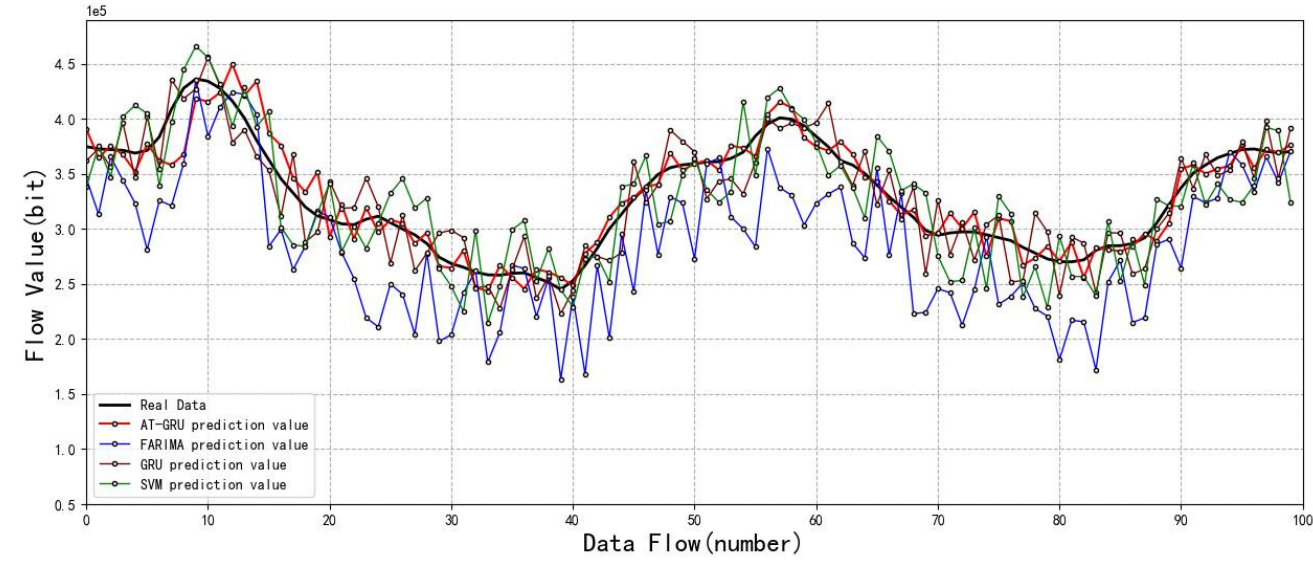
Figure 11. Model fitting effect.